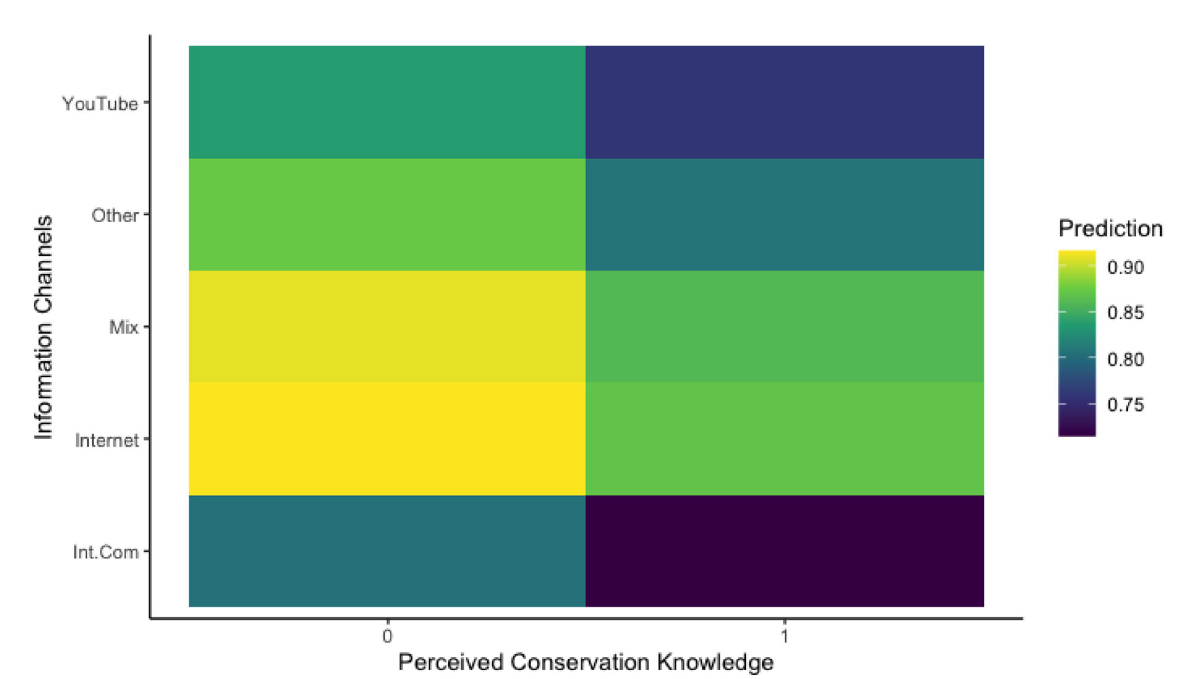
FIGURE1 Color-coded binary logistic regression model predictions (Model B) for Management Support considering all predictor variables. Information Channel categories displayed along the y-axis (Mix = Combination of channels, Int.Com = Interpersonal Communication), and Perceived Conservation Knowledge displayed along the x-axis (0 = Perceived themselves as not knowledgeable and 1 = Perceived themselves as knowledgeable). Model prediction values closer to a value of 1 (lighter colors) = Supportive of fishery management, model prediction values closer to 0 (darker colors) = Not supportive of fishery